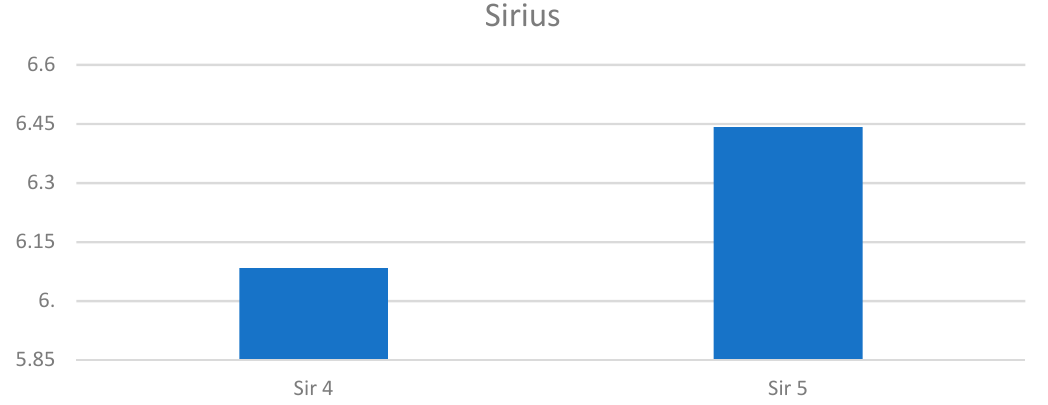
Figure 20. The comparison of specimens stained with trichrome before and after the treatment revealed 26.7% rise in collagen concentration.